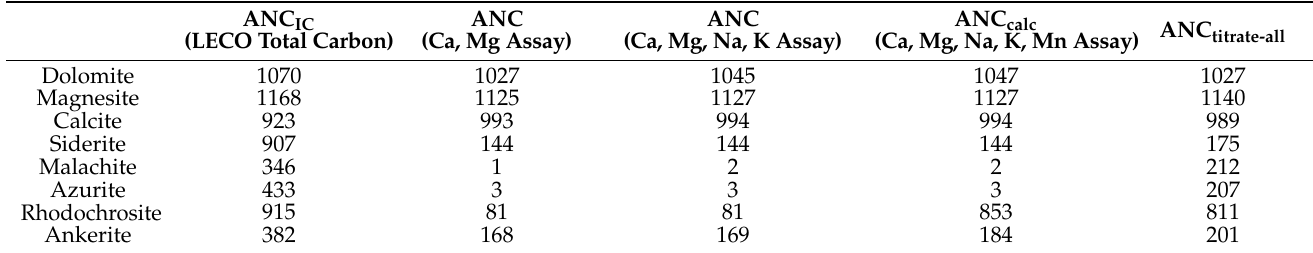
Table 2. Calculated ANC from bulk assay data and measured ANC by titration (ANC titrate-all , fizz rating 4, methodology (1)) for single-mineral carbonate samples. Units for all ANC are kg H 2 SO 4 t − 1 . ANC IC (LECO Total